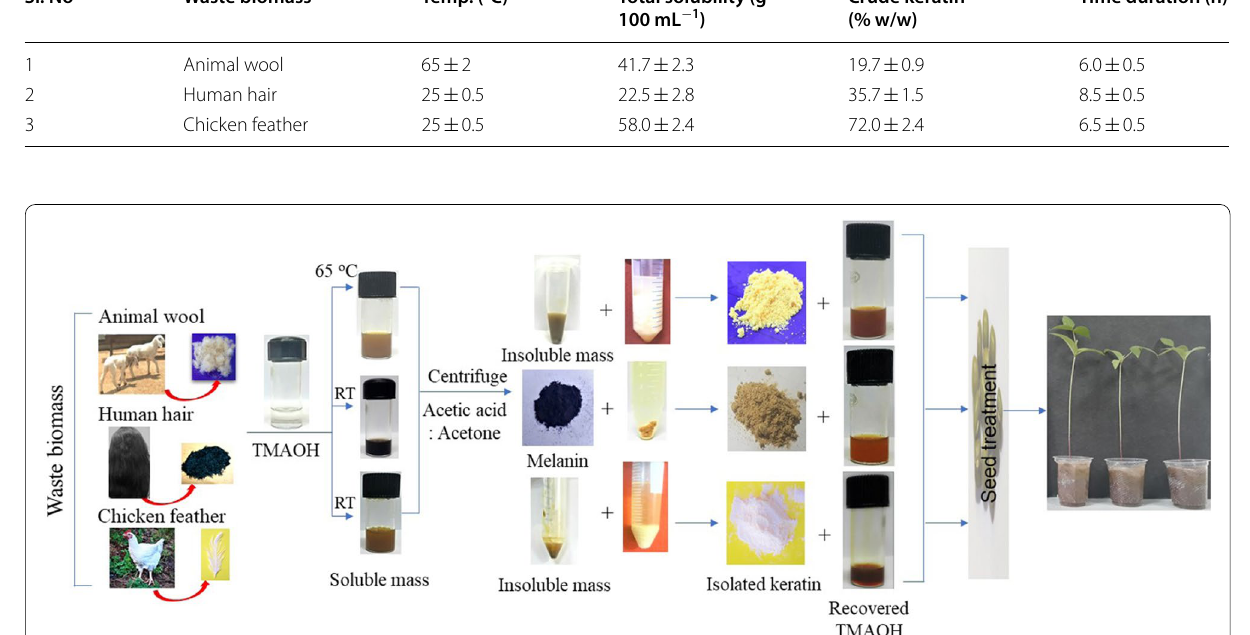
Table 1 Optimization of the process for the dissolution of waste biomass in TMAOH Sl.